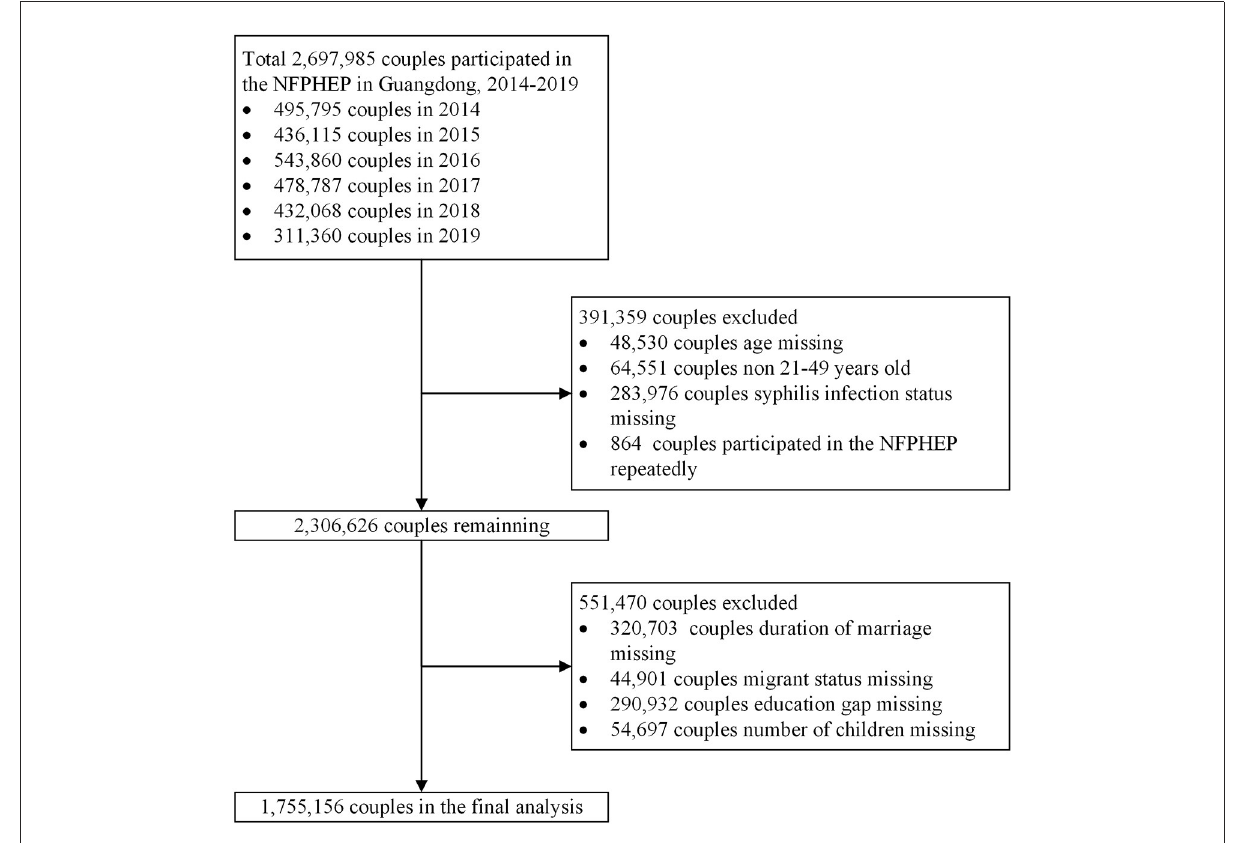
FIGURE2 Flow chart of participants in the National Free Preconception Health Examination Project (NFPHEP) in Guangdong Province, China during